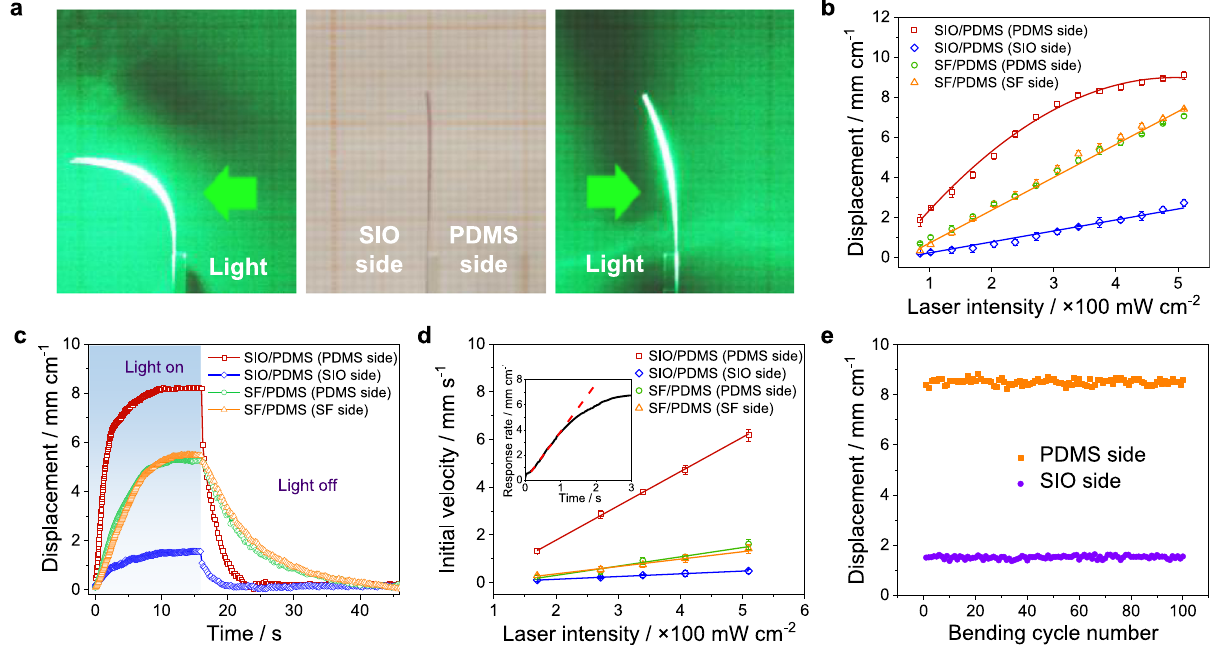
Fig. 2 Actuation performance of the photonic bilayers. a Deformation of a photonic bilayer strip (20× 2mm) in response to a green laser ( I = 17 mcm − 2 ). b Dependence of maximal displacement on laser intensity. c Dependence of displacement on the laser illumination time ( I = 35m cm − 2 ). d Response rate of bilayers in the initial deformation stage as a function of laser intensity. Inset shows the calculation of response rate, which is de fi ned as the slope of the tangent line. e Dependence of the displacement on the bending cycle number of photonic bilayer fi lm ( I = 35m cm − 2 ). Error bars represent the standard deviation of the measurements ( n =